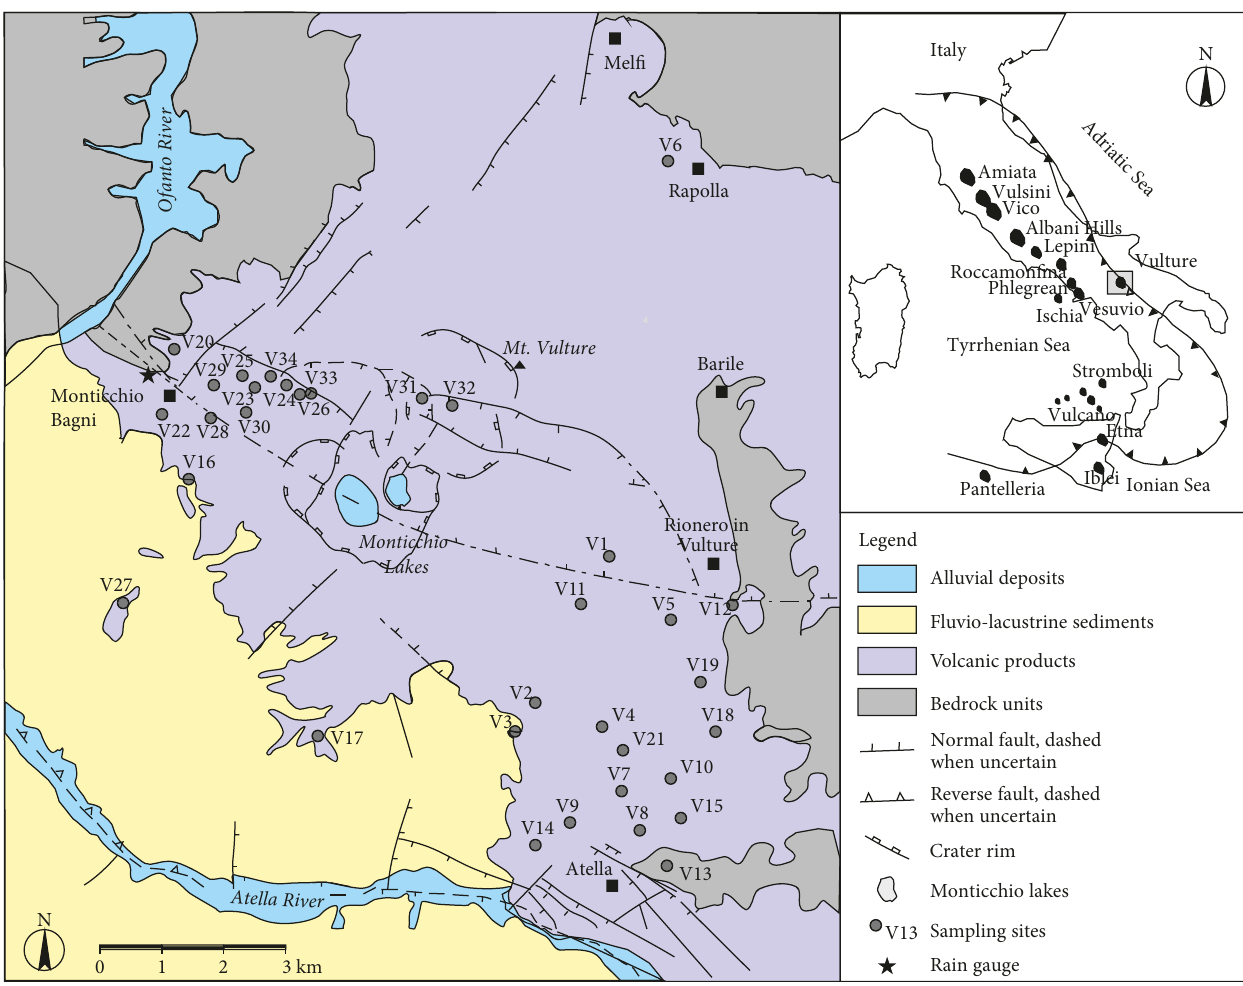
Figure 1: Geological sketch map of the Mt. Vulture area (modi fi ed from Giannandrea et al. [32]). The localization of sampling sites (grey circles), rain gauge (star), and code of the water samples are